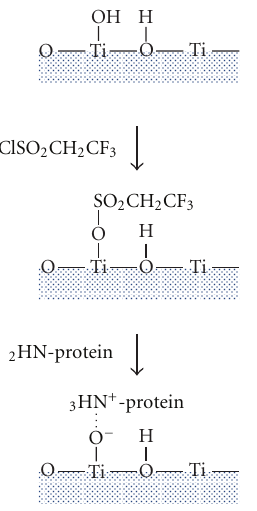
Figure 1: Presumed mechanism for fibronectin immobilization using tresyl chloride-activated